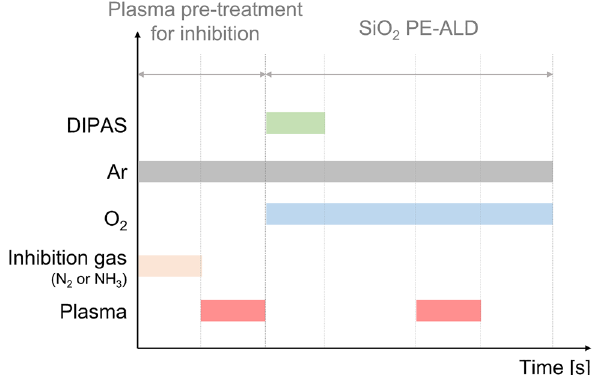
Figure 5. Schematic diagram of the process sequence constitution.